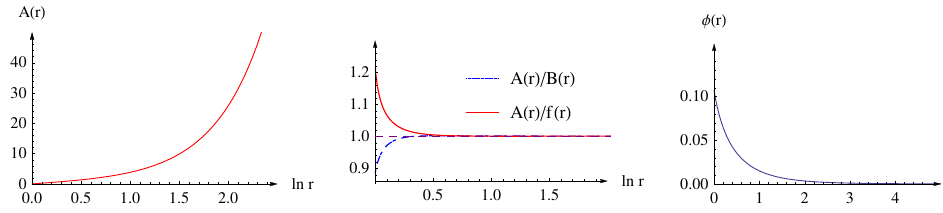
Figure 2. The scalarized AdS black hole with λ = 0.892 and − Λ /3 = 0.457 belonging to the